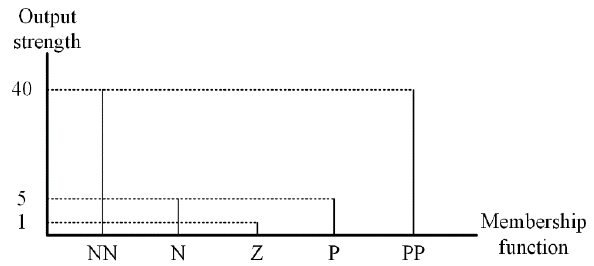
Figure 9. Output strength based on the DOM depending on the membership function.